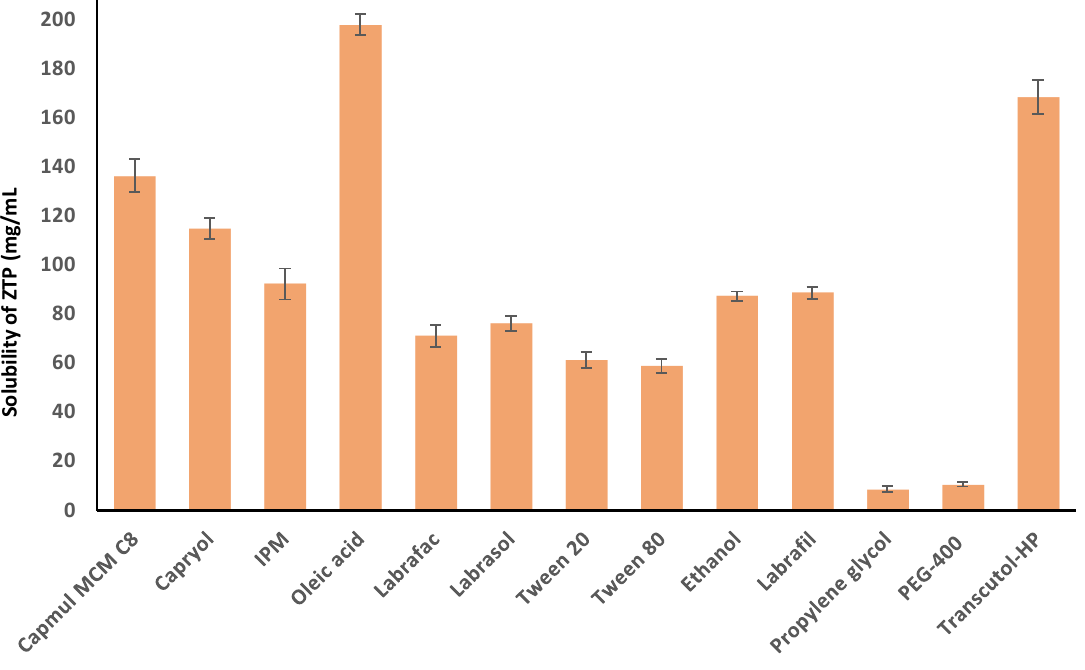
Figure 1. Solubility of ZTP in various vehicles (mean ± SD, n = 3).